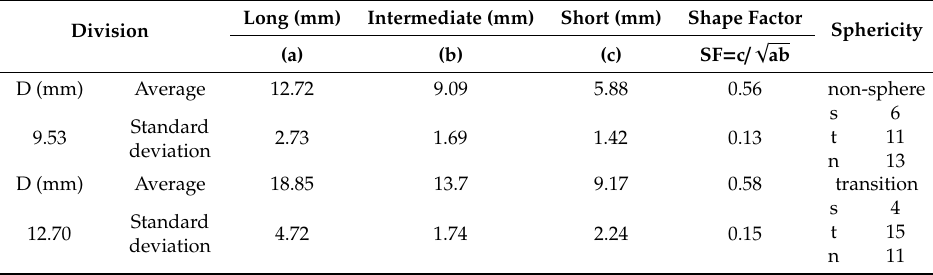
Table 2. Particle shapes of experiment